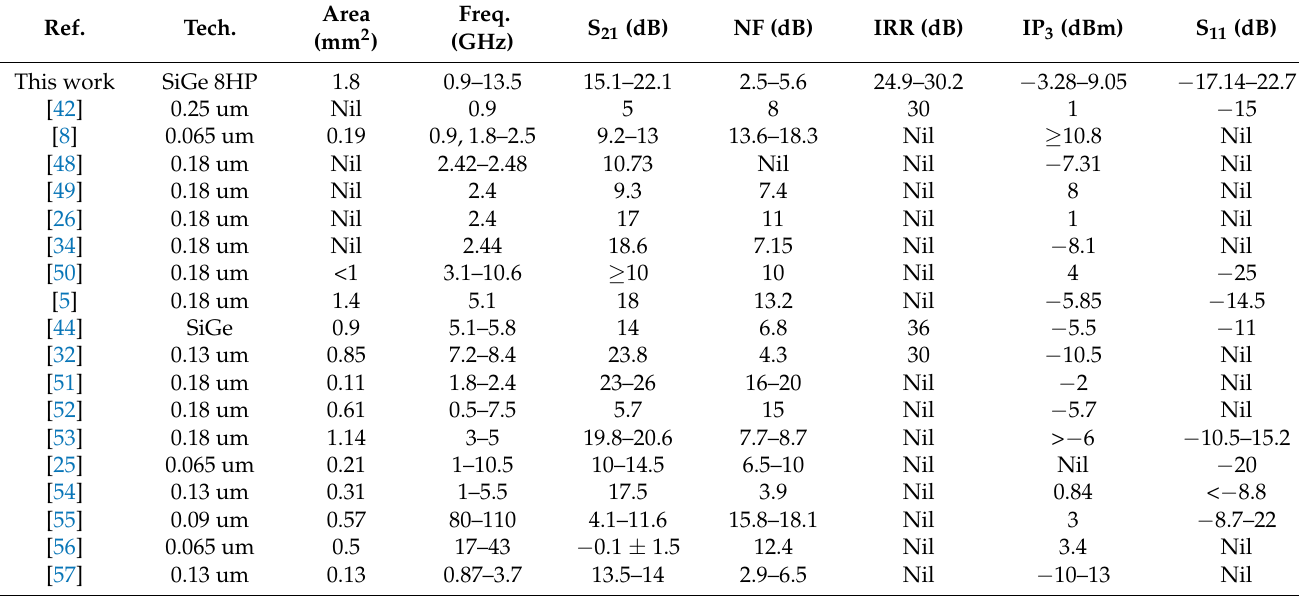
Table 1. Performance Comparison